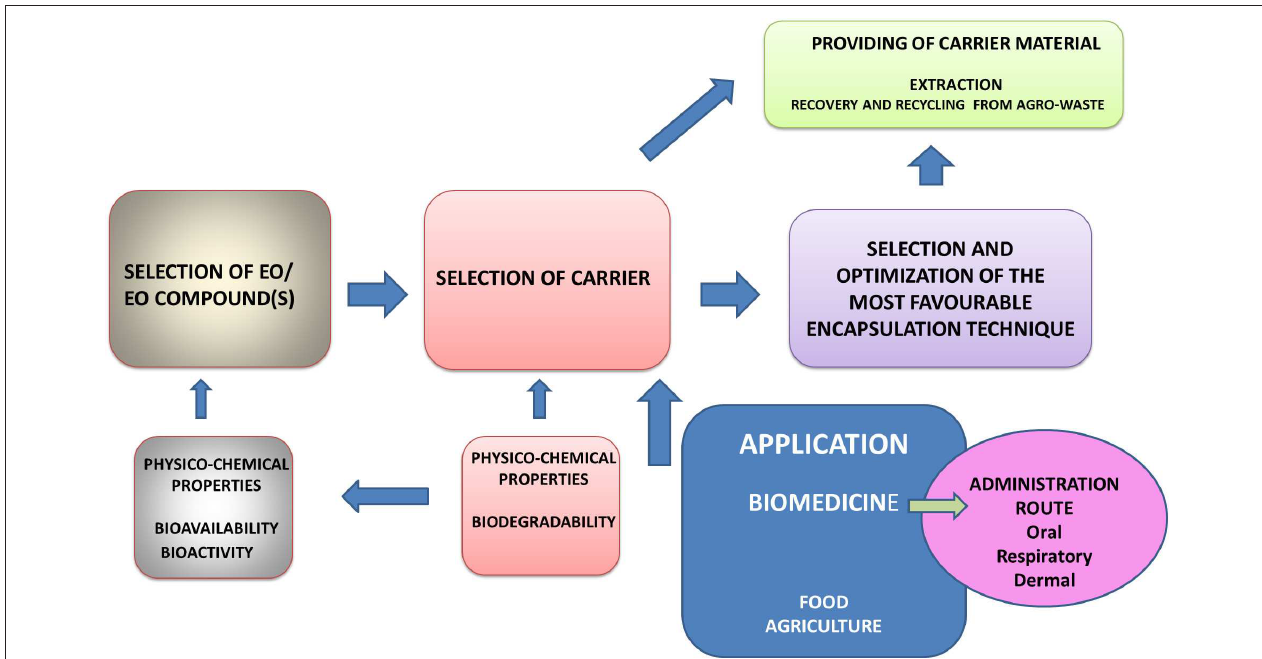
FIGURE 1 | Successive steps and their interrelations in selection and optimization of carrier system for EO